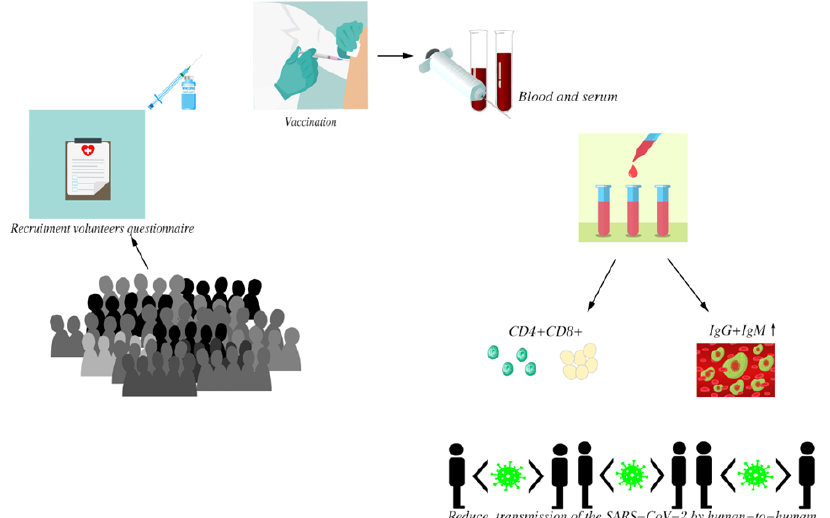
Figure 1. Research process flow diagram.